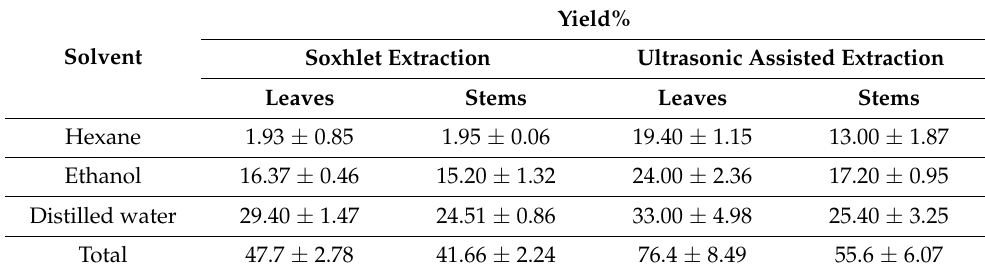
Table 1. Extraction yields of phenolic compounds from leaves and stems of Cynara cardunculus waste. Yield% Solvent Soxhlet Extraction Ultrasonic Assisted Extraction